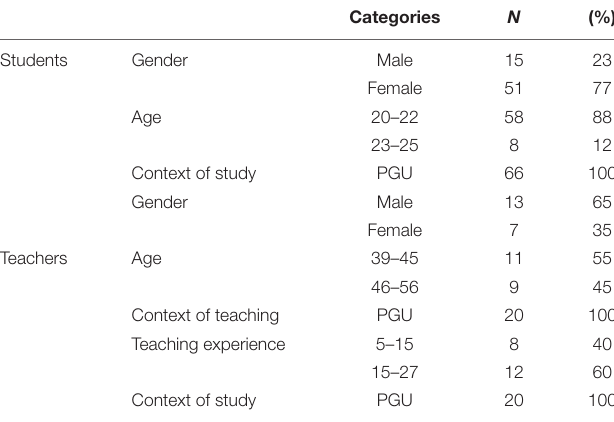
TABLE 1 | Demographics of the participants in the